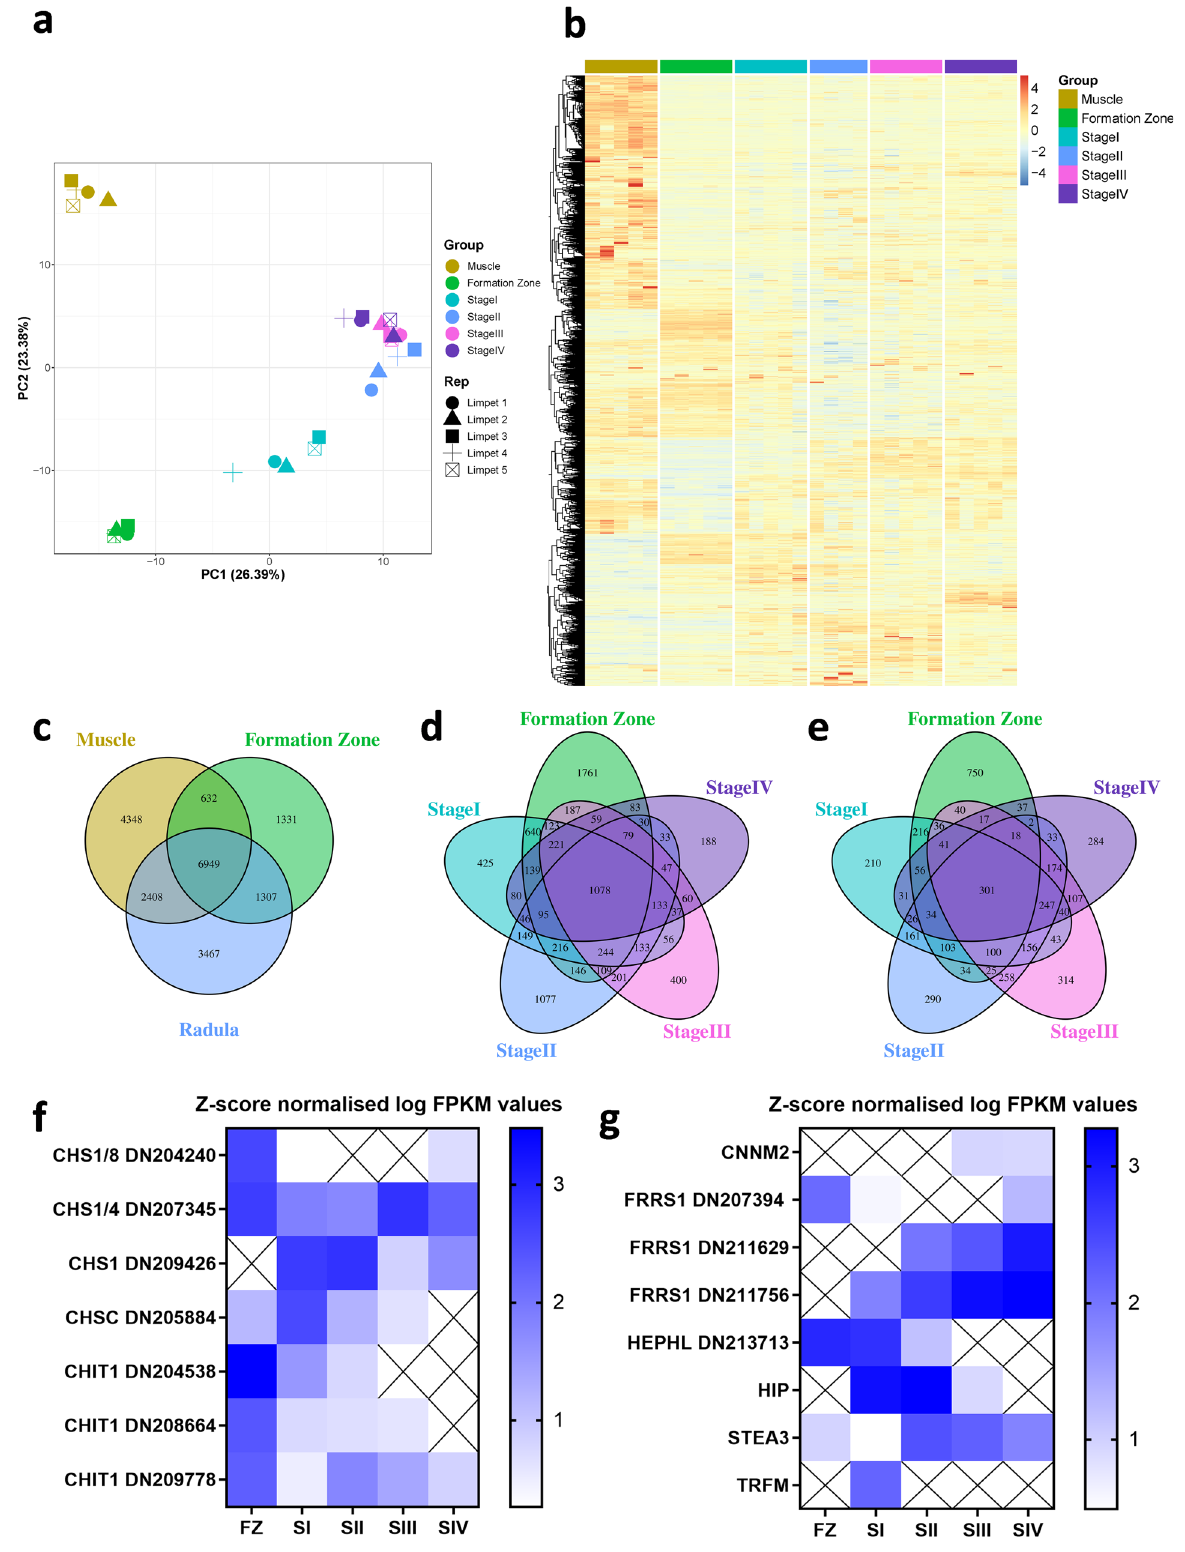
Fig. 2 The radula transcriptome and expression of key genes controlling limpet tooth formation. a Principal component analysis (PCA) demonstrating the relatednessoftranscriptexpressionbetweenlimpetmuscle,theFZandradulaStagesItoIV. b Heatmapshowingtheabundance(Z-scorenormalisedlogFPKMfor RNAseq) for all genes with differential expression across the limpet muscle, the FZ and radula transcriptomes. c Venn diagram showing overlap of geneexpression in the FZ, the radula and muscle. d – e Overlap between the genes upregulated, and downregulated respectively, in the radula compared to muscle, which was used as a common control. f – g Log FPKM values for RNA seq for genes involved in chitin and iron metabolism, respectively. CHS Chitin synthase, CHIT Chitinase, CNNM2 Cyclin and CBS domain divalent metal cation transport mediator 2, FRRS1 Ferric chelate reductase 1, HEPHL Hephaestin-like protein 1, HIP Heavy metal- binding protein HIP, STEA3 metalloreductase six-transmembrane epithelial antigen of prostate 3, TRFM Melanotransferrin. NATURE COMMUNICATIONS| (2022) 13:3753 |https://doi.org/10.1038/s41467-022-31139-0|www.nature.com/naturecommunications